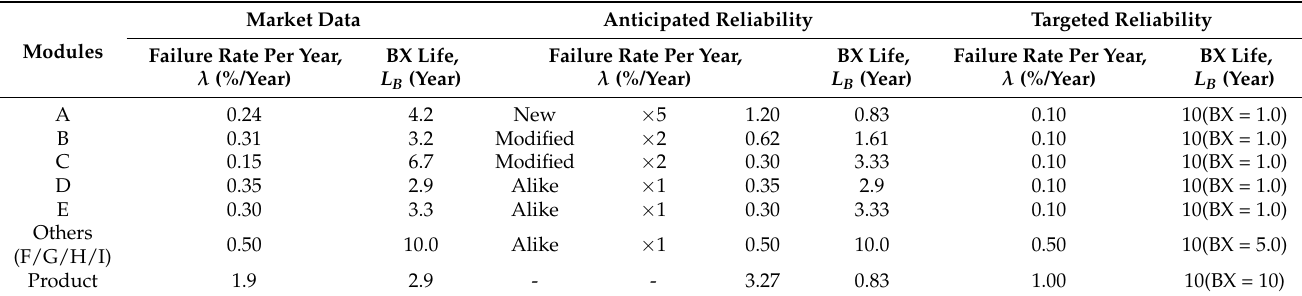
Table 1. Whole ALT scheme of mechanical modules in a machine tool.